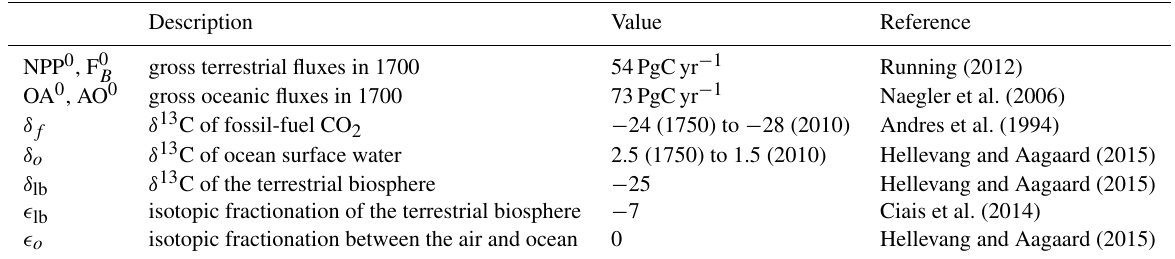
Table 4. Constants and parameters used to calculate resulting δ 13 C from the OSCAR simulations.